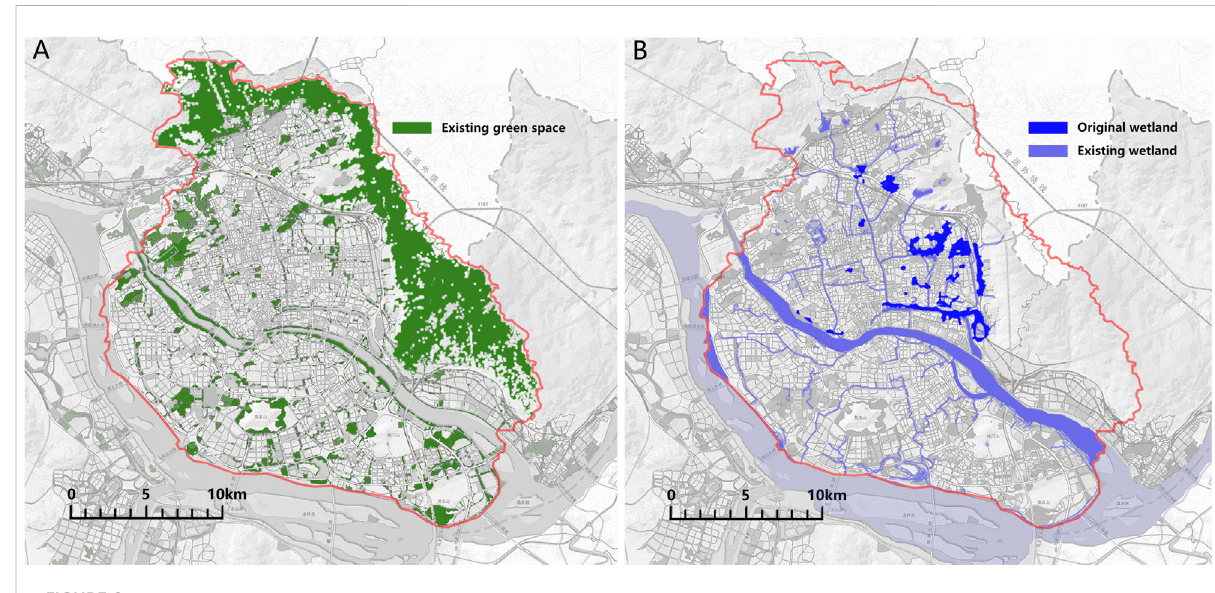
FIGURE 2 Blue and green space in the study area. (A) Original and existing wetland. (B) Existing green